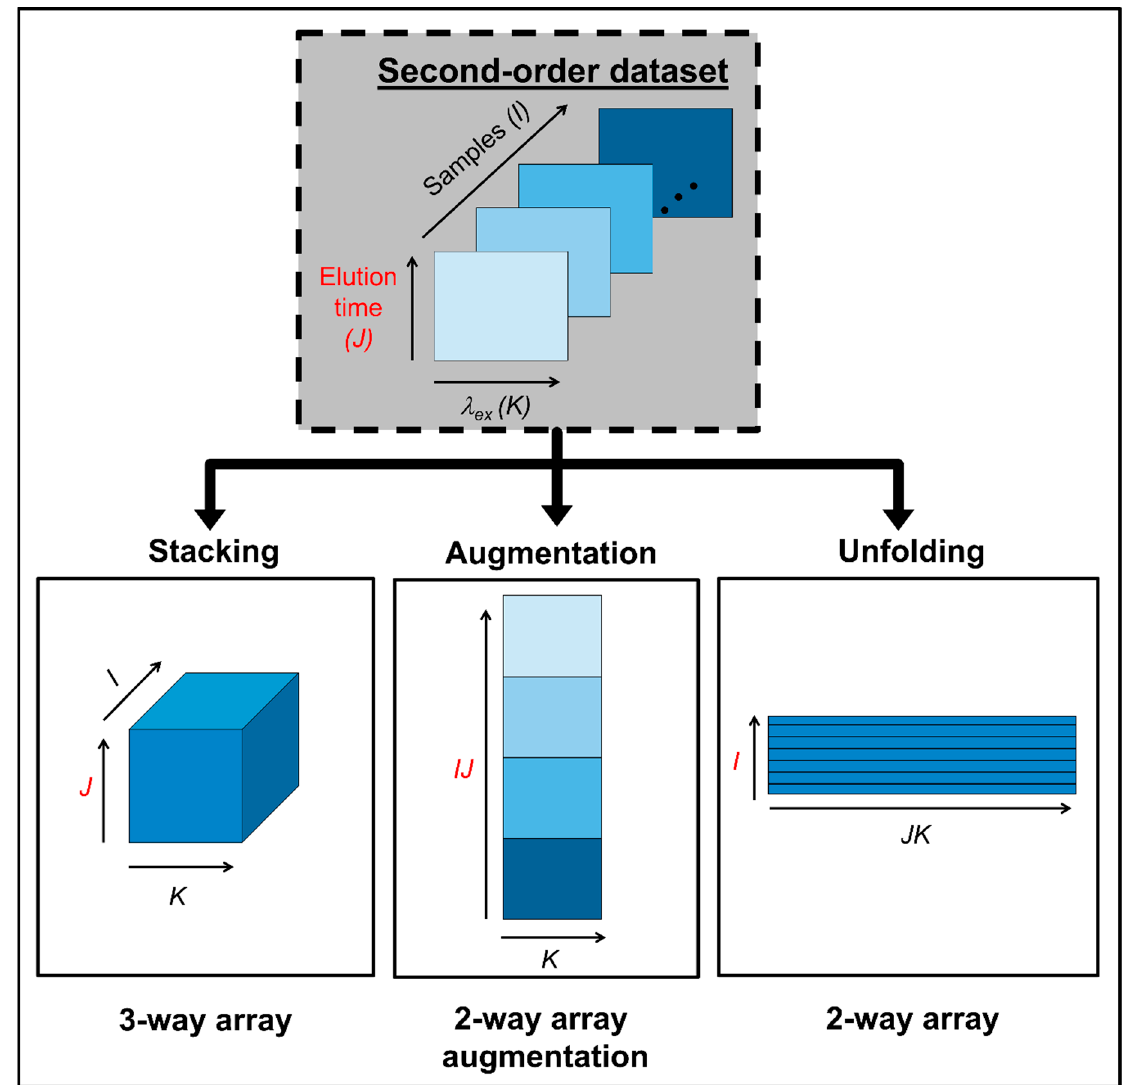
Figure 1. Possible data arrays that can be built with second ‐ order data prior to chemometric modelling.